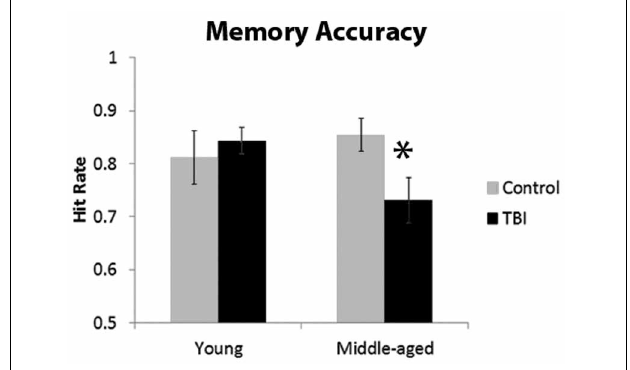
FIGURE 2 | Behavioral data from memory paradigm, ∗ p < 0 . 05. Error bars are ± one standard error of the